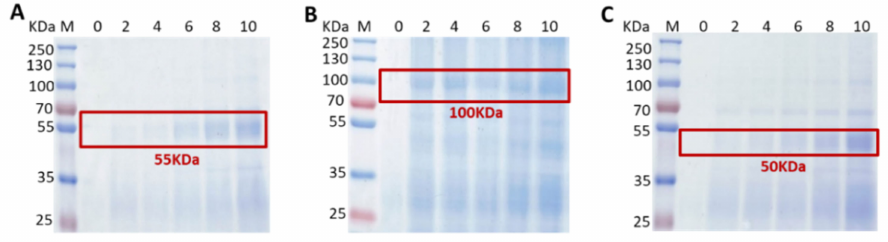
Figure 3. Detection of binding activity of the fusion proteins on GEM particles by SDS-PAGE. ( A – C ) The maximum binding capacity of each fusion protein binding to the GEM particles when 0.5 U GEM particles were combined with 0, 2, 4, 6, 8 and 10 mL of each recombinant baculovirus culture supernatant. All target proteins are boxed out in red. ( A ) G-eG N was present as a 55 kDa protein; ( B ) G-eG C was present as a 100 kDa protein; ( C ) G-NAb was present as a 50 kDa protein. M: molecular weight marker; 0: GEM